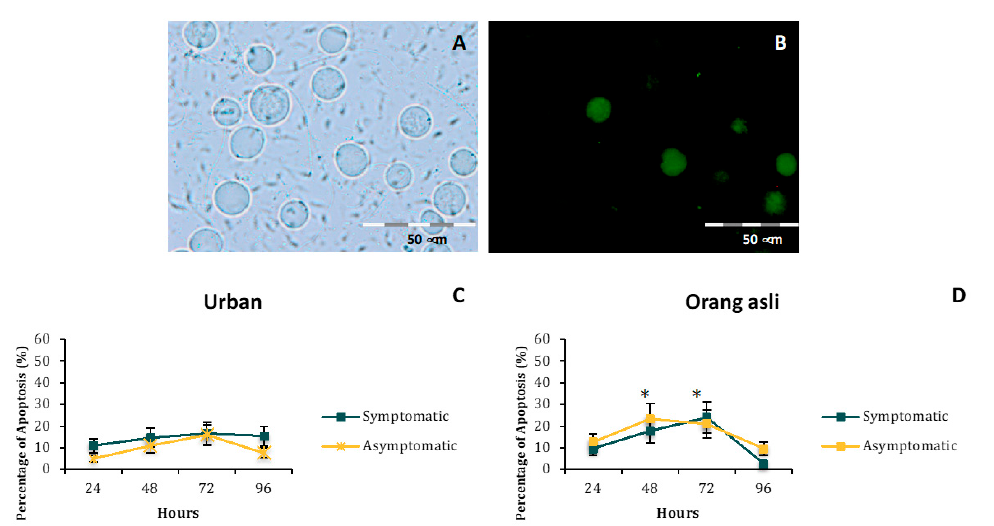
Figure 2. The average number of granular forms ( A , B ) and amoebic forms ( C , D ) of Blastocystis sp. isolated from urban and orang asli individuals. Values are expressed as mean ± SD. * p < 0.05 is the comparison between granular forms of symptomatic isolates.